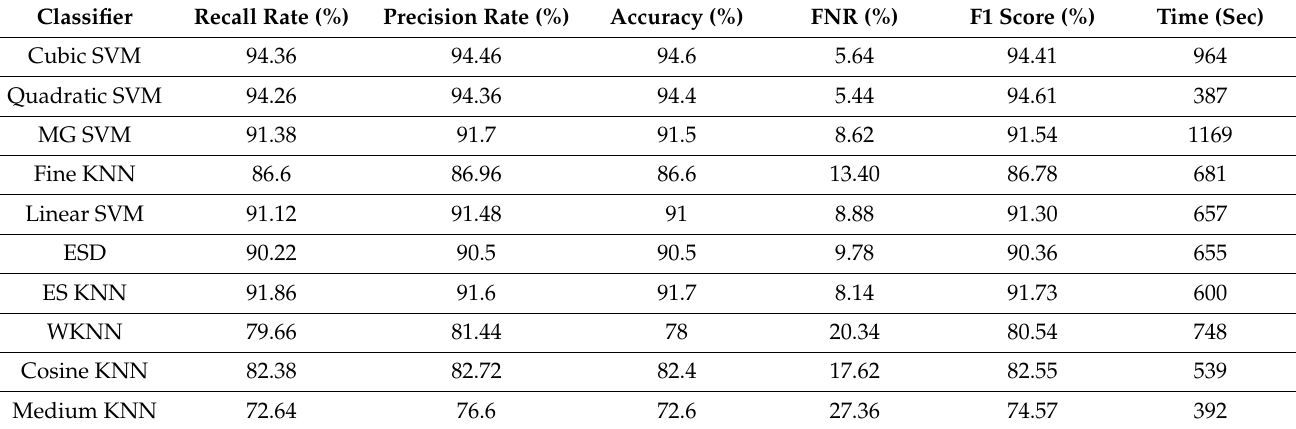
Table 4. Classification results of fine-tuned ResNet50 deep model after data augmentation.